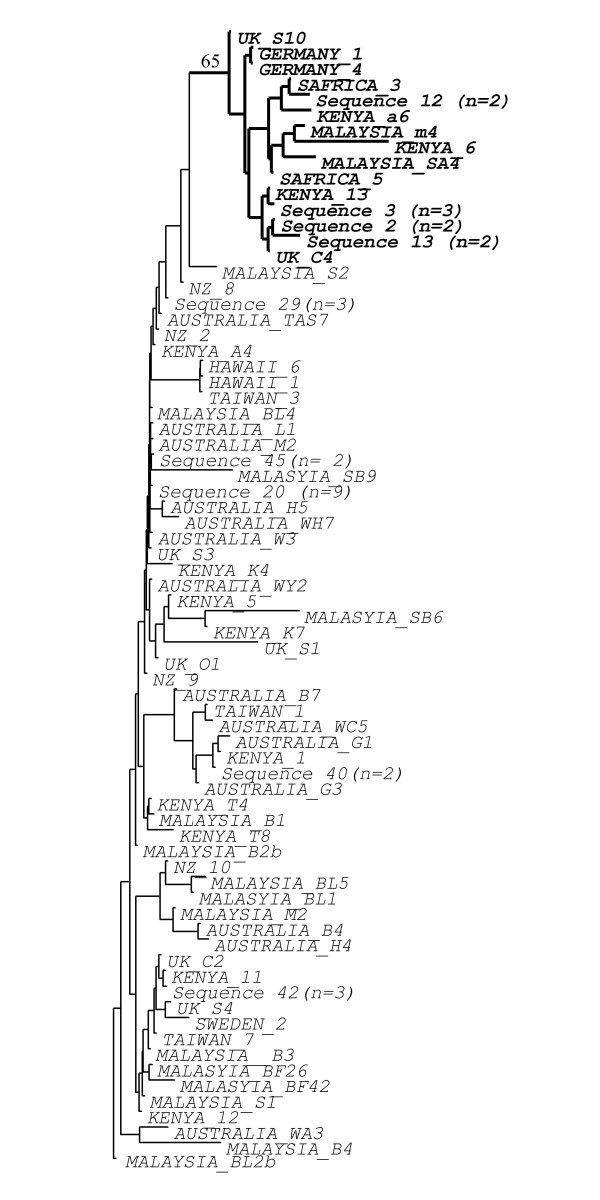
Phylogeny of DBM moths using nuclear data. Neighbour-joining tree of the 74 different Plutellaxylostella nuclear DNA (L27a gene) sequences. Numbers in brackets show multiple individuals with the same DNA sequence. The clade with bold labels and thick lines is supported by a major indel (see text) and has bootstrap support of 65. Country of origin is given for sequences found only in one moth. Sequences have been deposited in Genbank with accession numbers EU833259–833333.